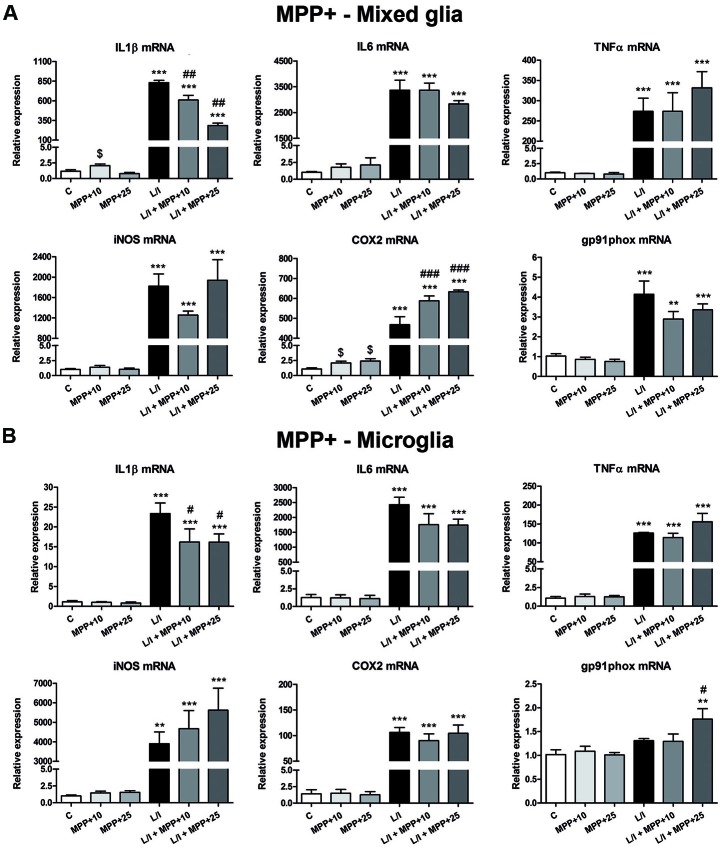
Effect of MPP+ treatment on the mRNA expression of pro-inflammatory markers. mRNA expression of pro-inflammatory cytokines [interleukin-1β (IL-1β), IL-6 and tumor necrosis factor-α (TNF-α)] and enzymes [inducible nitric oxide synthase (iNOS), cyclooxygenase-2 (COX-2), gp91phox] in the primary mixed glial cultures (A) and microglial cultures (B) treated for 6 h with 10 and 25 μM MPP+, both in the absence and the presence of LPS/IFN-γ (L/I). 18S ribosomal RNA (Rn18s) and β-actin were used as housekeeping genes. Bars are means ± SEM of four independent experiments. **p < 0.01 and ***p < 0.001 vs. C; #p < 0.05, ##p < 0.01 and ###p < 0.001 vs. L/I; one-way ANOVA and Newman-Keuls post-test. $p < 0.05 MPP+ alone vs. C, one-way ANOVA and Newman-Keuls post-test only considering the L/I-free groups. This latter analysis was performed to detect whether the high values observed in the L/I group may hinder the detection of statistical significance of the effects of MPP+ alone.